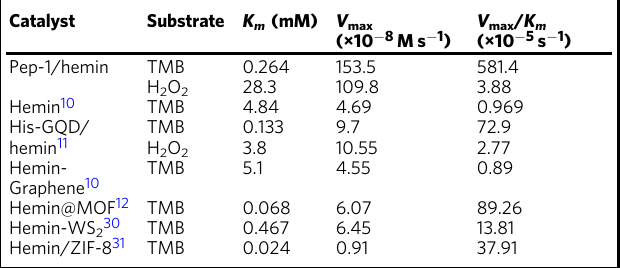
Table 1 Comparison of kinetic parameters of Pep-1/hemin and other hemin-containing peroxidase